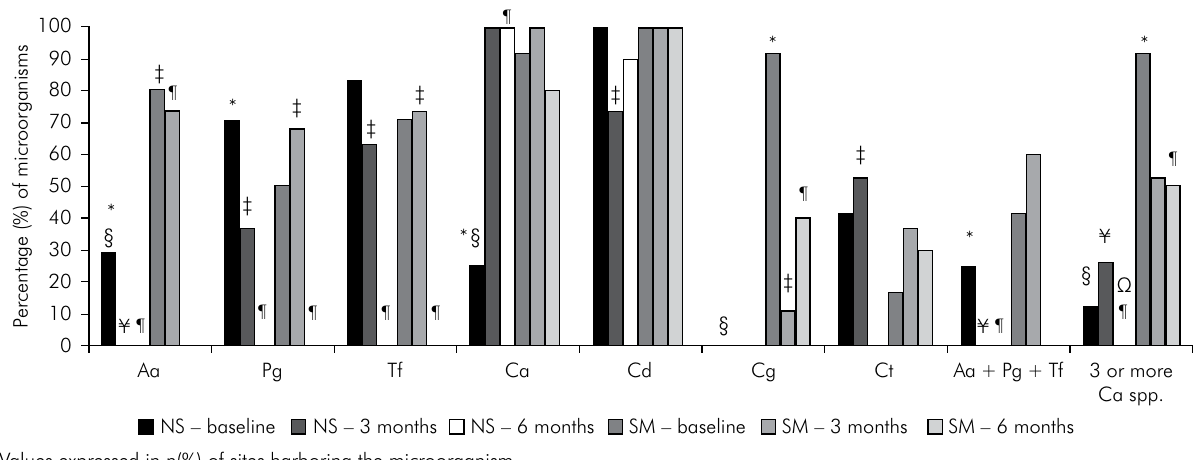
Values expressed in n(%) of sites harboring the microorganism. *Statistically significant difference between baseline and 3 months, considering each group separately (Wilcoxon’s test; p < 0.05); ¶ Statistically significant difference between baseline and 6 months, considering each group separately (Wilcoxon’s test; p < 0.05); ‡ Statistically significant difference between 3 months and 6 months, considering each group separately (Wilcoxon’s test; p < 0.05); § Statistically significant differences between SM and NS groups for baseline (Mann Whitney test; p < 0.05); ¥ Statistically significant differences between SM and NS groups for 3 months (Mann Whitney test; p < 0.05); Ω Statistically significant differences between SM and NS groups for 6 months (Mann Whitney test; p < 0.05). Figure 1. Microbiological evaluation of smokers and nonsmokers at baseline and after 3 and 6 months of periodontal